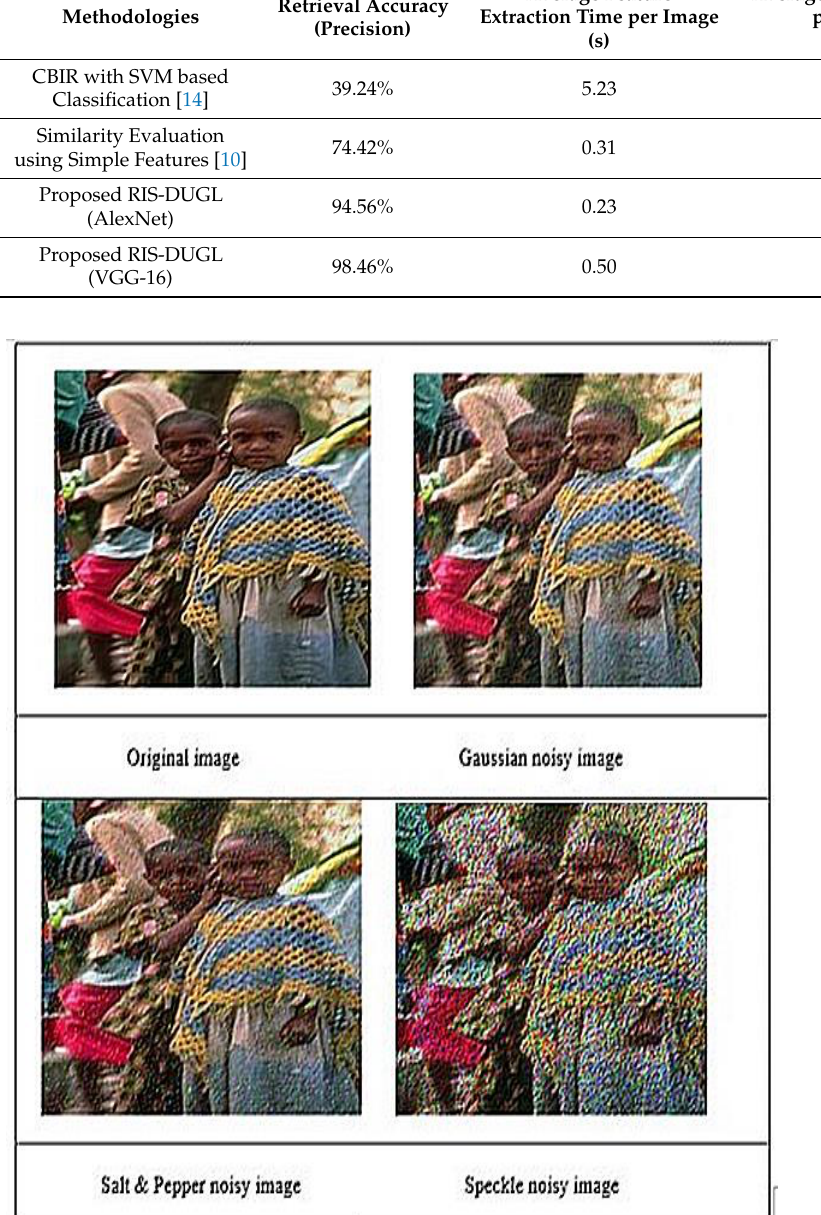
Figure 16. Sample images corrupted with three types of noise.